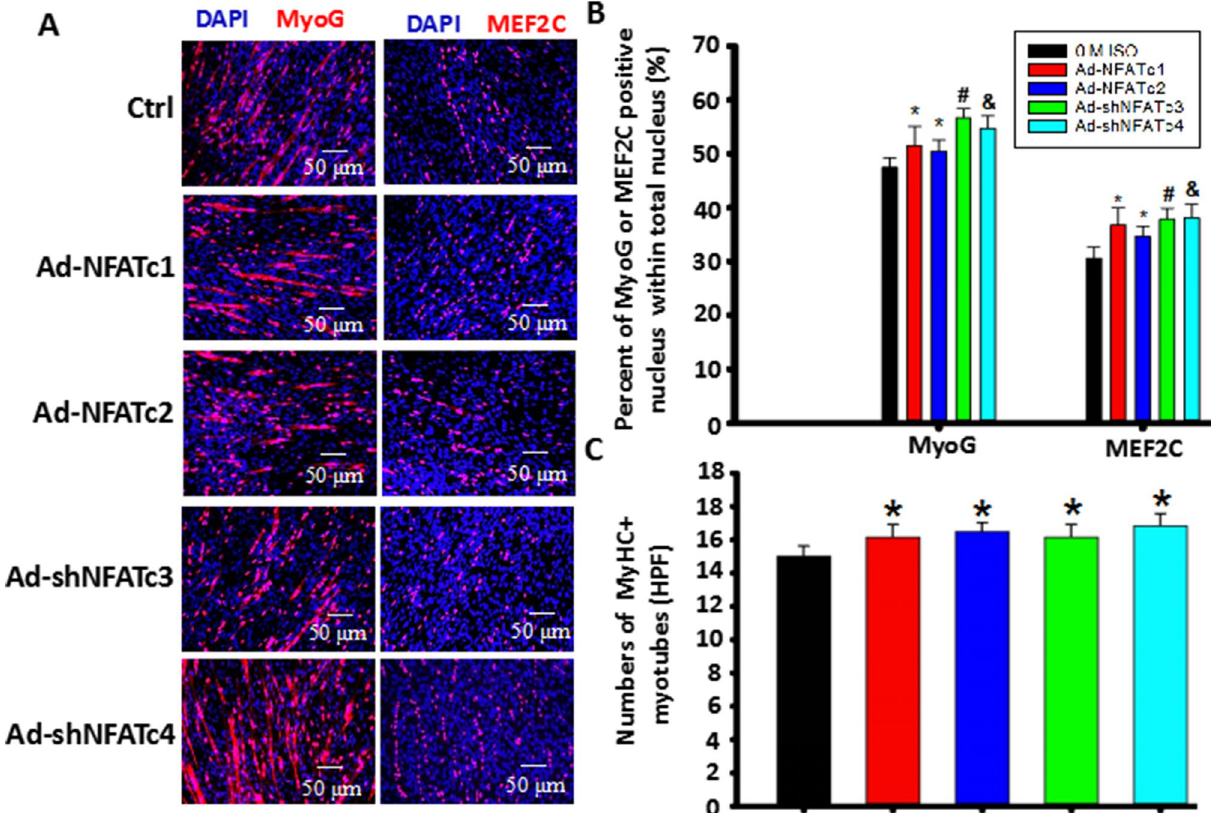
Figure 8. MyoG and MEF2C are involved in C2C12 myoblast differentiation mediated by the NFAT signaling pathway. Myoblast cells were cultured under DM for six days and then stained with MyoG or MEF2C 24 h after the cells were transfected with Ad-NFATc1, Ad-NFATc2, Ad-shNFATc3 or Ad-shNFATc4 at 100 MOI. Blue: DAPI-stained nuclei; Red: MEF2C or MyoG. ( B ) Quantitative assay for the number of MyoG or MEF2C + nuclei in the cells with less than 3 nuclei from 8A. n = 3, @ P < 0.05 versus Ctrl; *P < 0.05 versus ISO group; & P < 0.05 versus ISO + Ad-NFATc1 group; $ P > 0.05 versus ISO + Ad-NFATc1 group; # P < 0.05 versus ISO + Ad-NFATc1 group. ( C ) Quantitative assay for the number of MEF2C + nuclei in the cells with more than 3 nuclei from 8A. n = 3, @ P < 0.05 versus Ctrl; *P < 0.05 versus ISO group; & P < 0.05 versus ISO group; $ P > 0.05 versus ISO